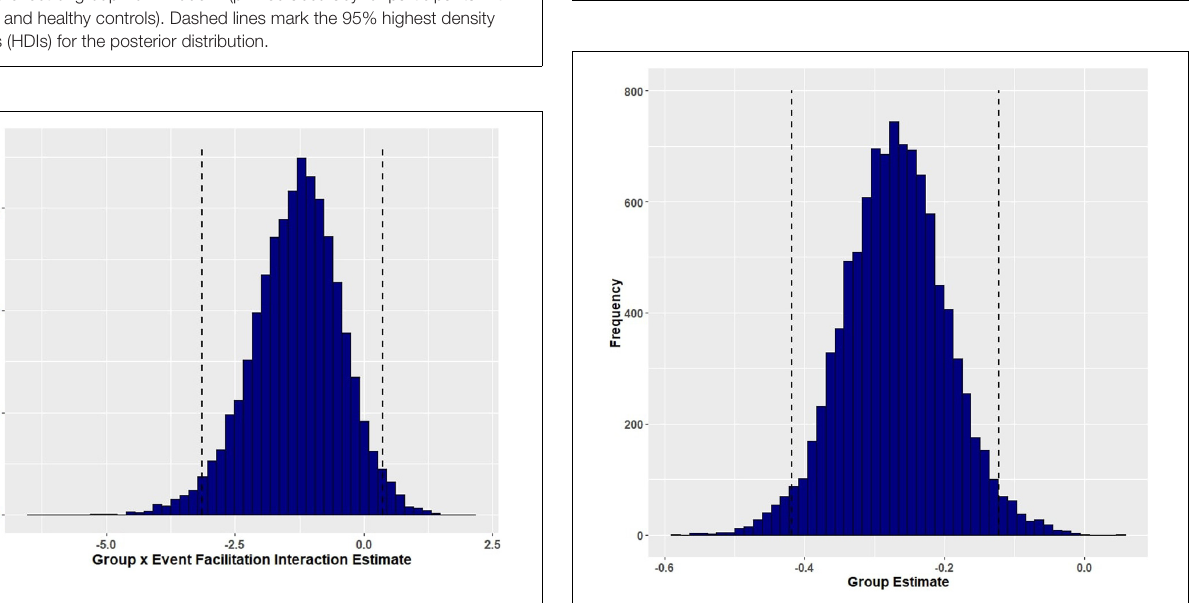
95% HDI = [ − 0.024, 0.056]) or lexical co-occurrence conditions ( β = 0.010, EE = 0.017, and 95% HDI = [ − 0.024, 0.044]). The full set of results is reported in Table 9 .